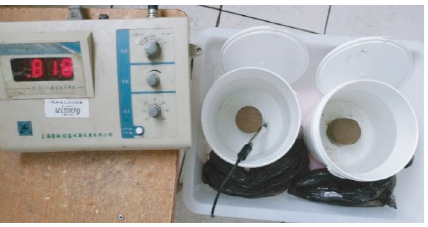
Figure 3: Digital conductivity